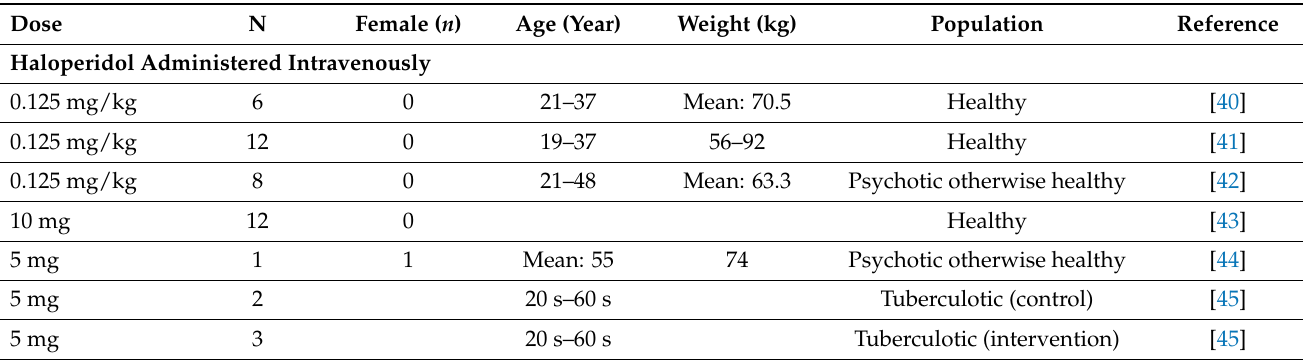
Table 1. List of clinical pharmacokinetic studies used for developing and evaluating the haloperidol PBPK